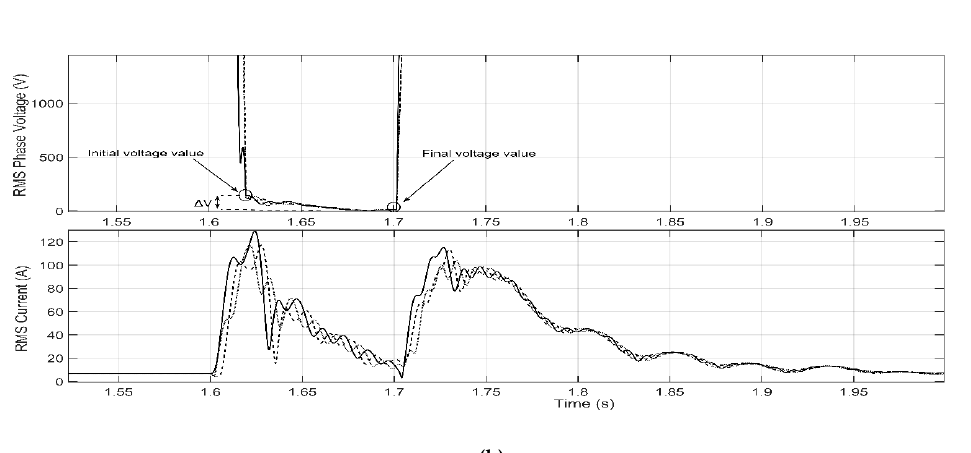
Figure 3. Example of a non-constant voltage sag produced for a three-phase fault with IMs. ( a ) RMS voltage and current during the event; ( b ) enlarged section of the voltage sag characteristic.